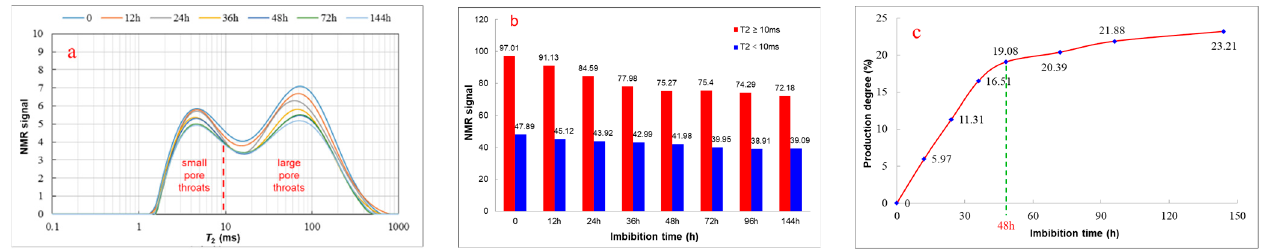
Figure 12. Imbibition NMR results of core samples of type I reservoir; ( a – c ) are the T 2 spectrum of imbibition NMR, the histogram of NMR signal at different imbibition times and the variation of production degree of crude oil in the pore throats of IR-07, respectively.